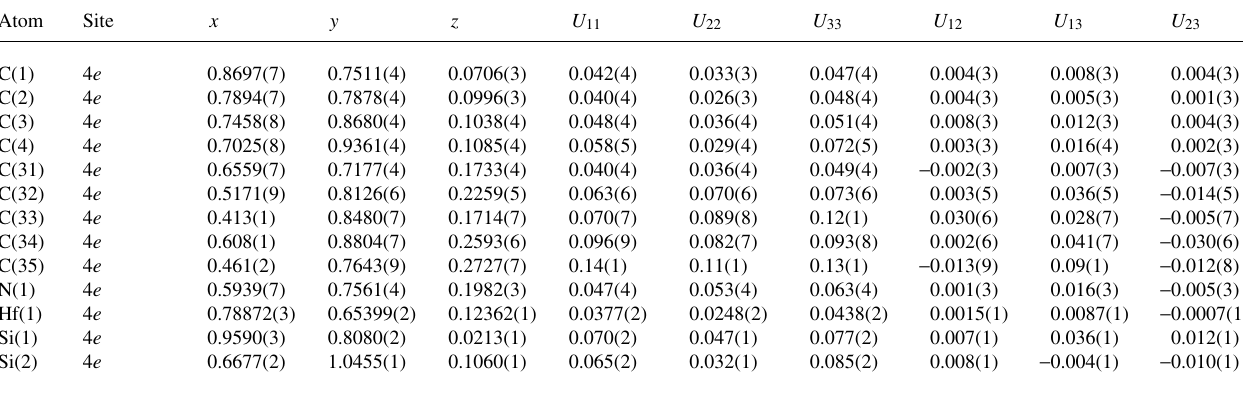
Table 3. Atomic coordinates and displacement parameters (in Å 2 )